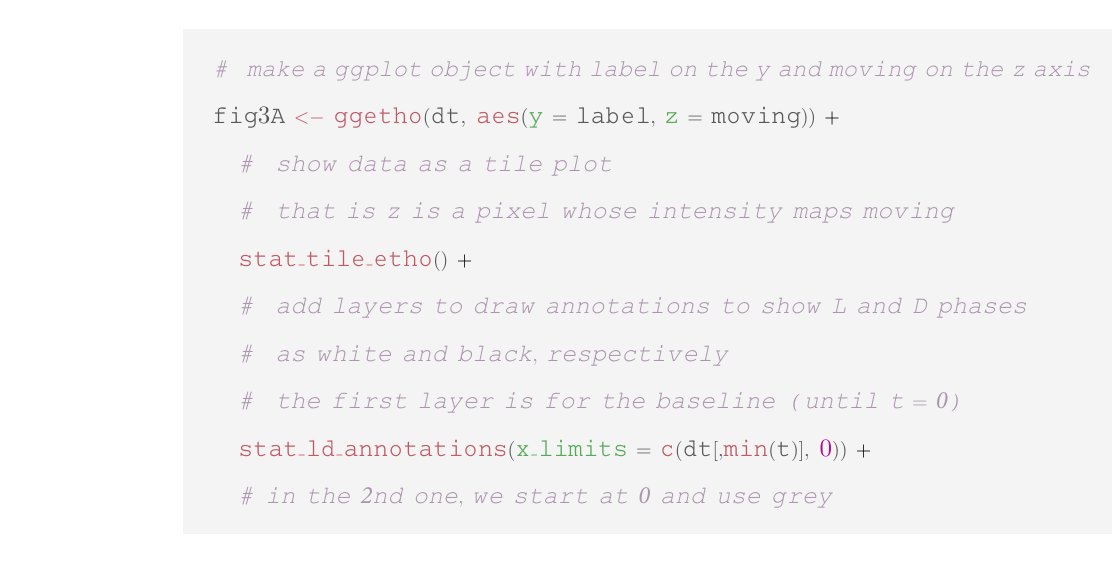
Fig 3. Experiment quality control. Tile plot showing the fraction of time spent moving as a colour intensity. Each individual is represented by a row and time, on the x-axis, is binned in 30 minutes consecutive epochs. A: Uncurated raw data. B: Data after the curation step. Time was trimmed and data from dead animals removed. The red ‘+’ symbols show animals that were removed from the subsequent analysis as they did not survive five complete days in LL. The white and black rectangles on the time axis show L and D phases, respectively. In the LL regime (for t > 0), grey rectangles represent subjective nights.